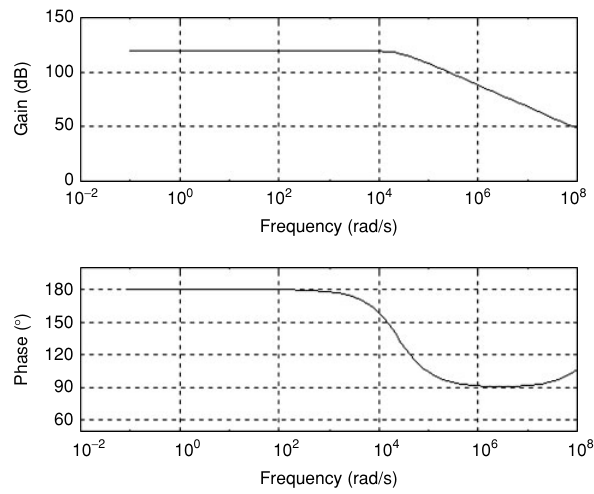
Figure 3 Graph of Bode for the photodiode